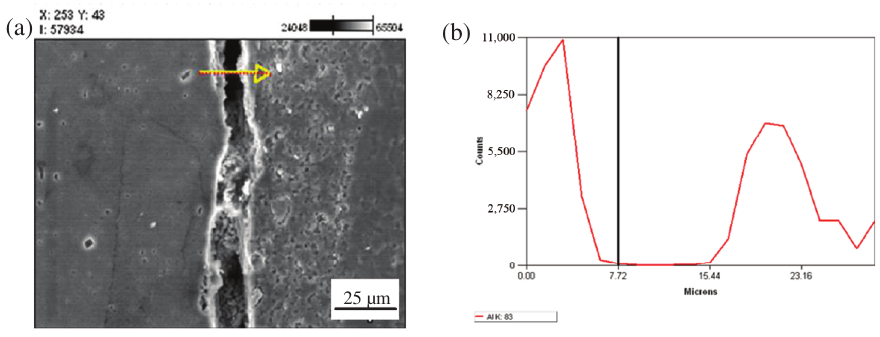
Figure 11: (a) SEM micrograph from the area marked by the white arrow in Figure 8(a) and (b) view of the associated line scanning showing the aluminum.